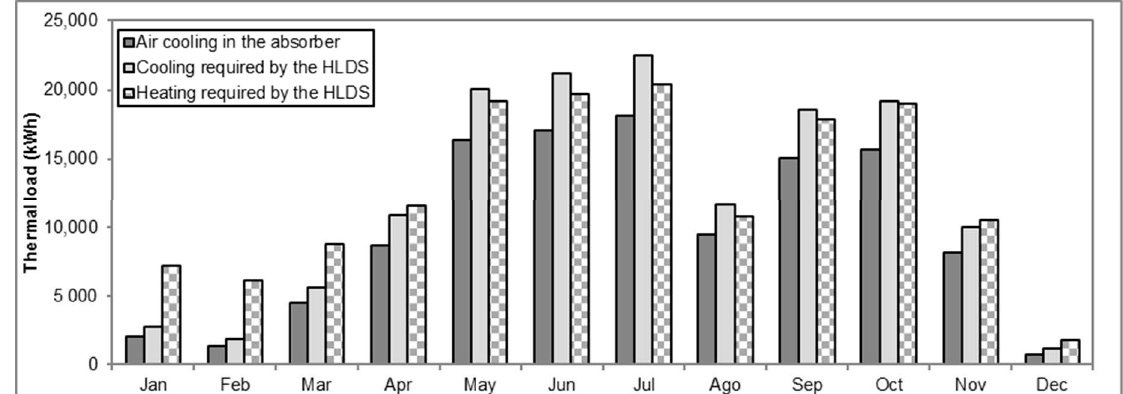
Figure 10. Monthly results of the different thermal loads calculated from the monthly optimized control strategy.